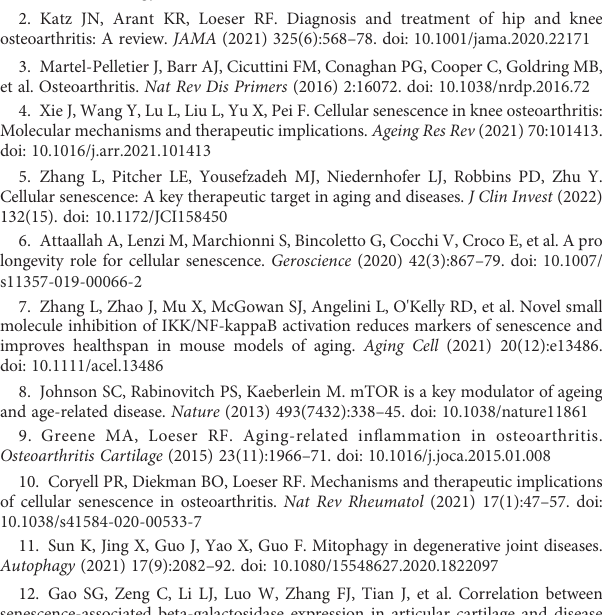
SUPPLEMENTARY FIGURE 5 The mRNA expression levels of key leading-edge proteins in the human knee cartilage samples.Real-time PCRanalysis was usedto assessthe mRNA levels ofNDRG2,WSB1,BAG3,JMJD6, TSPYL2,HMGB2,CCNL1,TIPARP,PPP1R15A, GADD45B, TRIB3, MAFF and ATF3 in smooth and damage cartilage from human OA patients (n = 10 per group). All data are expressed as the mean